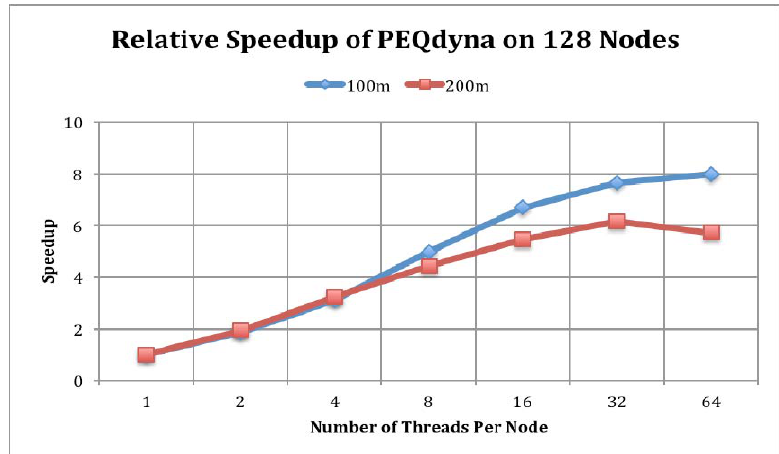
Figure 9. Performance comparison of PEQdyna on 128 Nodes with different number of threads per